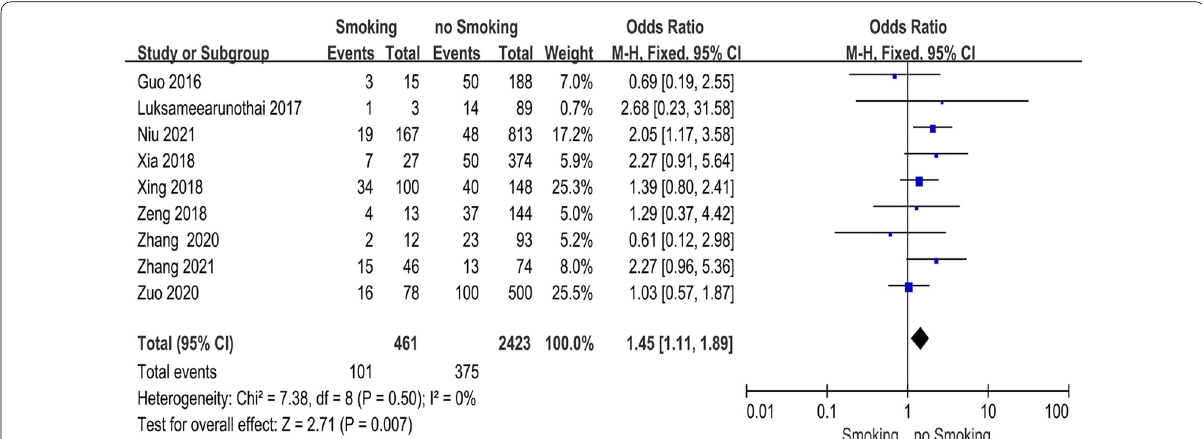
Fig. 10 Forest plot showing a history of smoking in 2 groups. CI confidence interval, df degrees of freedom, M-H Mantel–Haenszel